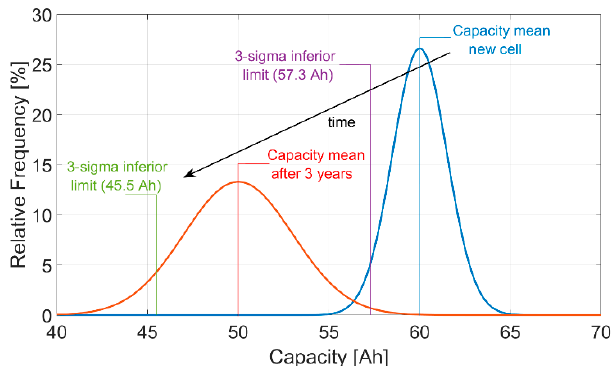
Figure 6. Normal distributions of cell capacities at the beginning of life (BoL) ( σ = 1.5%) and after 3 years ( σ = 3%).